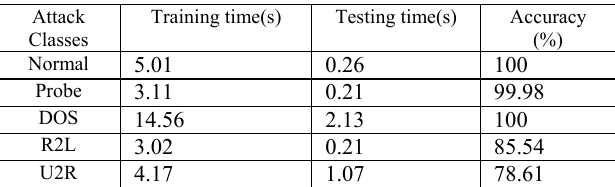
Table 5. Performance of the improved SVM